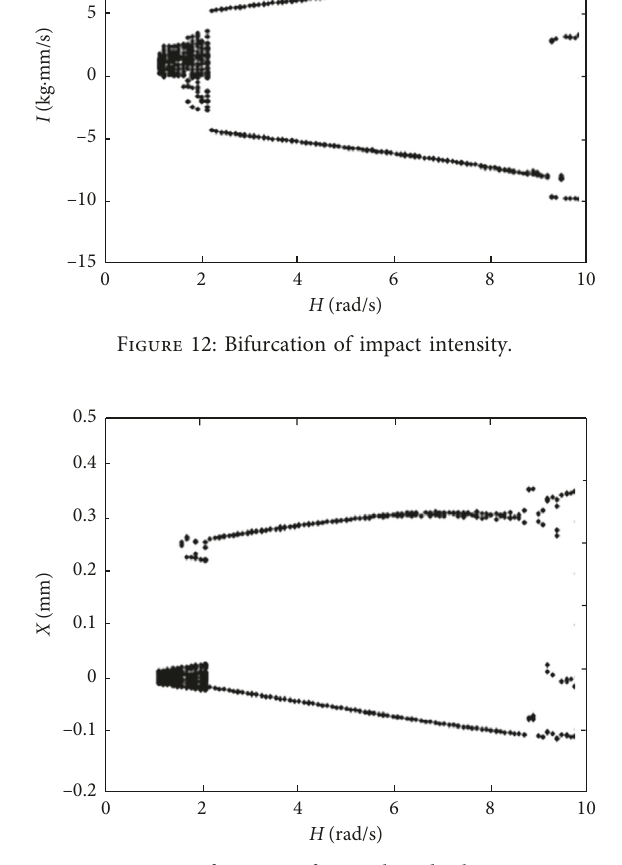
Figure 13: Bifurcation of equivalent